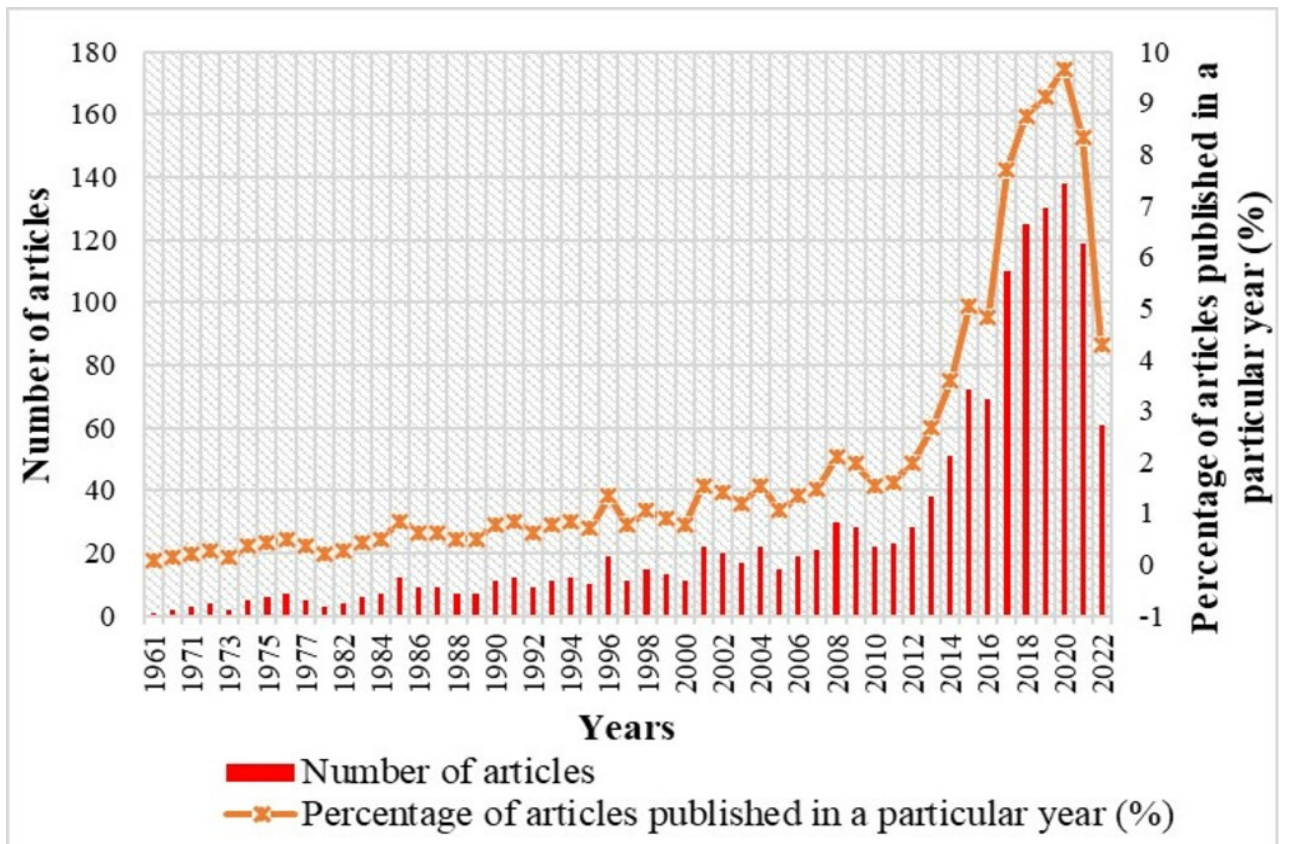
Figure 1. Global annual trend of YIG from 1961 to 2022.